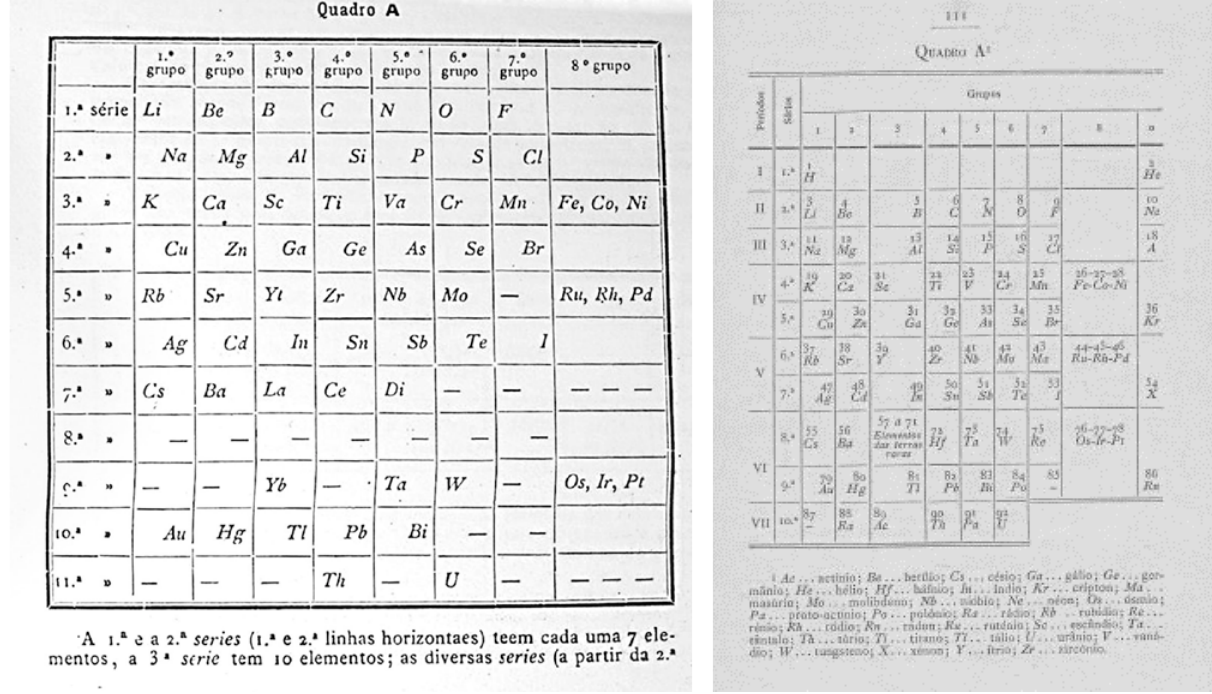
Figure 3. Two presentations of the periodic classification in textbooks from the same author, the first in 1906 from Achilles Machado, op. cit , (ref. 87, pp. 95-98) and the second in 1938, in Achilles Machado, op. cit. (ref. 91, pp.